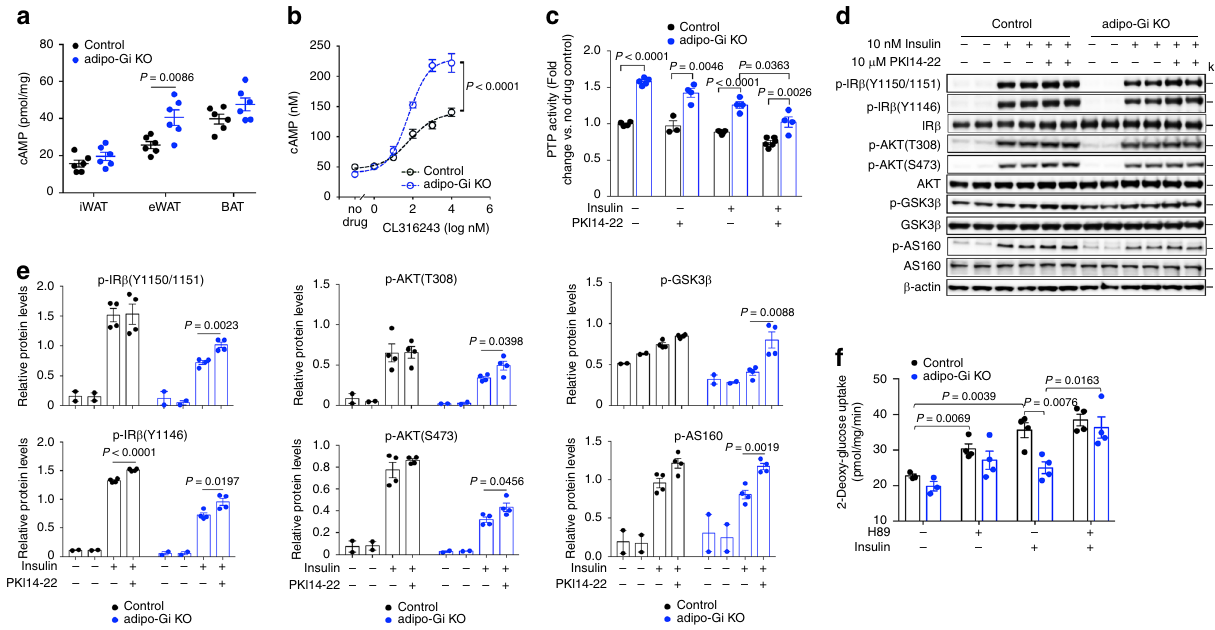
Fig. 8 De fi cient adipocyte G i function enhances cAMP/PKA signaling and PTPase activity, causing impaired insulin signaling. a cAMP levels in adipose tissues from HFD adipo-Gi KO and control mice (males; n = 6 per group). b CL316243-induced stimulation of cAMP accumulation in primary adipocytes (iWAT) from control and adipo-Gi KO mice ( n = 8 per group). c PTPase activity in primary adipocytes from adipo-Gi KO and control mice treated with either saline or insulin (10 nM) for 5 or 10 min, either in the absence or presence of PKA inhibitor (10 μ M PKI14-22) (control, n = 3; adipo-Gi KO, n = 4). d Immunoblots showing the effect of PKA inhibition on insulin-stimulated phosphorylation of IR β -Y1150/1151, IR β -Y1146, AKT-T308, AKT-S473, GSK3 β , and AS160 in primary adipocytes prepared from iWAT of adipo-Gi KO and control mice (diet: regular chow) were treated with 10 nM insulin for 5 or 10 min, either in the absence or presence of PKI14-22 (10 μ M) (n = 4 per group). e Quanti fi cation of Western blotting data shown in ( d ). f Insulin-stimulated 2-deoxyglucose uptake by primary adipocytes. Primary adipocytes prepared from iWAT of adipo-Gi KO and control mice were treated with 10 nM insulin for 5 min, either in the absence or presence of H89 (10 μ M) ( n = 4 per group). Data are presented as means ± s.e.m. P values are indicated in the different panels (two-way ANOVA followed by Bonferroni ’ s post hoc test). PKI14-22, myristoylated PKI [14 – 22] amide. Source data are provided as a Source data fi